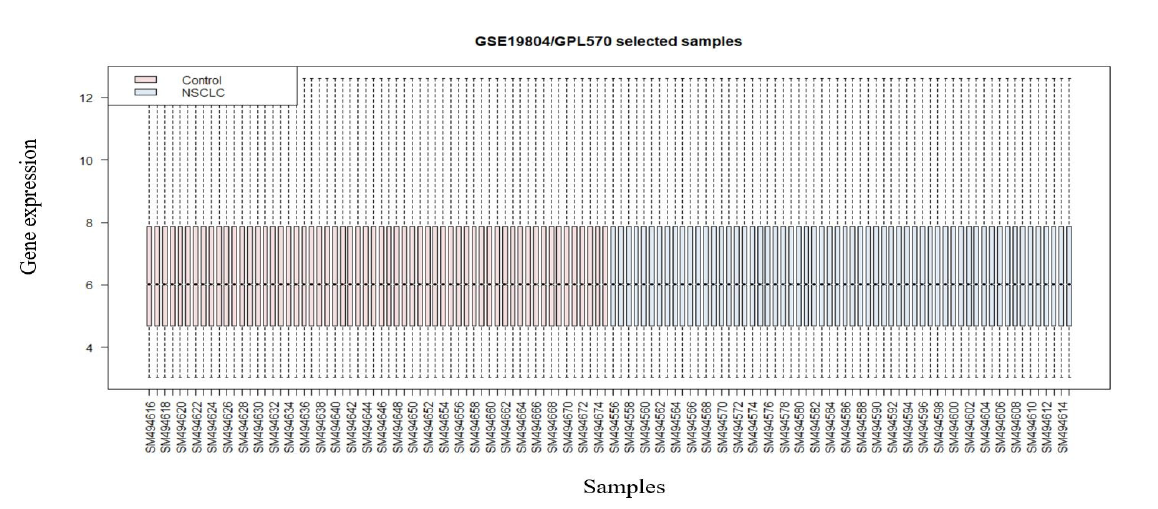
Figure 1. Boxplot of normalized GSE19804